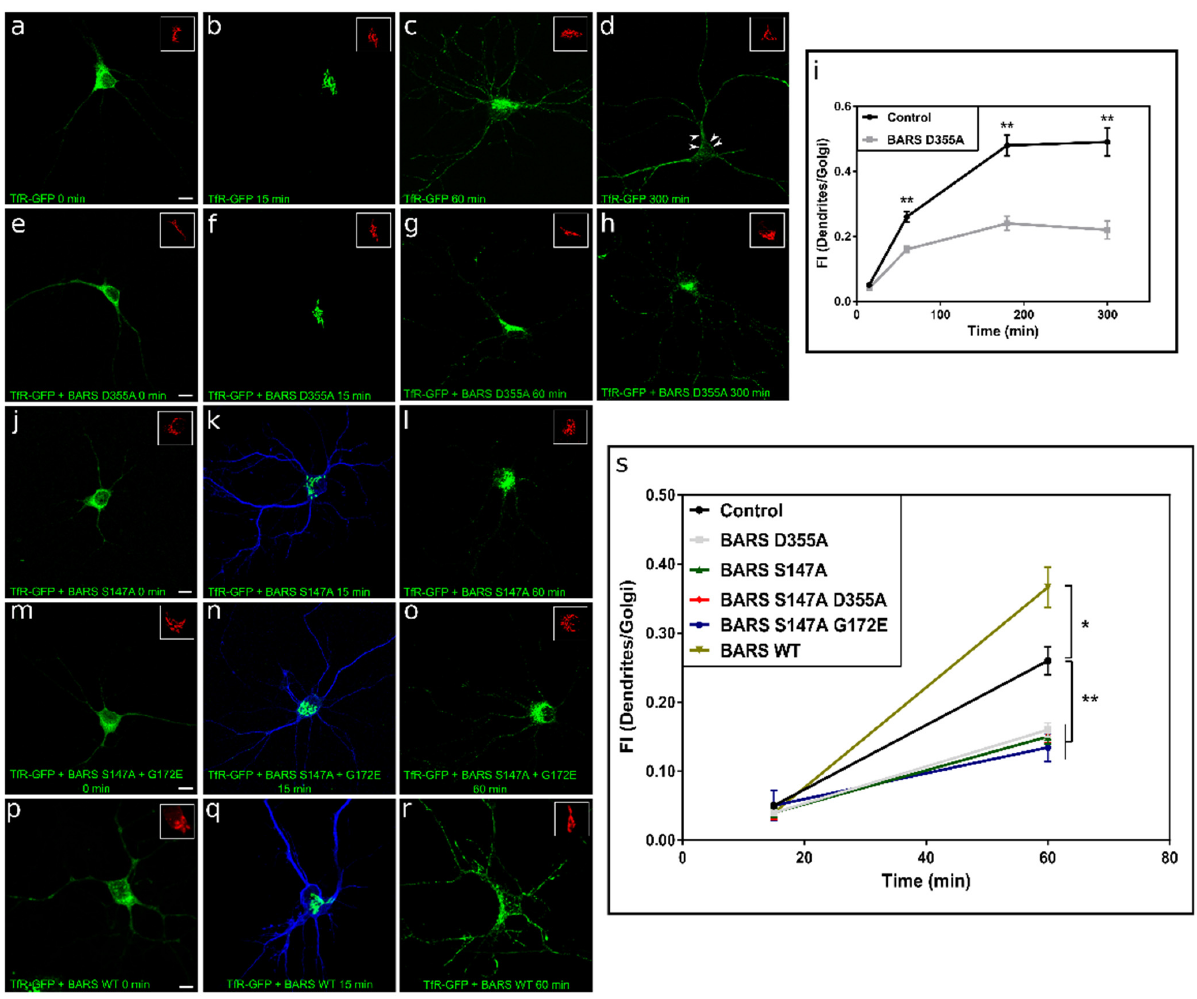
Figure 4. BARS regulates trafficking of TfR. ( a – h ) A series of confocal images showing the distribu- tion of ectopically-expressed TfR-GFP-FM4 alone or after co-transfection with BARS D355A. The distribution of TfR-GFP-FM4 is indicated at different time points after the addition of DD solubilizer. Inset, distribution of the Golgi apparatus marker TGN38 (red). In control cells (GFP-transfected) most of the TfR-GFP labeling disappeared from the Golgi region 300 min after the addition of DD ( d ); the arrowheads in ( d ) indicate the presence of the labeling close to the dendritic plasma membrane. By contrast, in neurons co-expressing the BARS fission-defective mutant most of the labeling remains in the Golgi area ( h ). Scale bar: 10 µ m. ( i ) Graphs showing the fluorescent intensity (FI) ratio between TfR-GFP labeling in dendrites and the Golgi area at 15, 60, 180, and 300 min after the addition of DD solubilizer in control and in neurons expressing BARS D355A mutant. ( j – o ) A series of confocal images showing the distribution of ectopically-expressed TfR-GFP-FM4 after co-transfection with BARS S147A (blue in k) or BARS S147A G172E (blue in n). The distribution of TfR-GFP-FM4 is indicated at different time points after the addition of DD solubilizer. Inset, distribution of the Golgi apparatus marker TGN38 (red). Scale bar: 10 µ m. ( p – r ) A series of confocal images showing the distribution of ectopically-expressed TfR-GFP-FM4 after co-transfection with BARS WT (blue in ( q )). The distribution of TfR-GFP-FM4 is indicated at different time points after the addition of DD solubi- lizer. Inset, distribution of the Golgi apparatus marker TGN38 (red). Scale bar: 10 µ m. ( s ) Graphs showing the fluorescent intensity (FI) ratio between TfR-GFP labeling in dendrites and the Golgi area at 15 and 60 min after the addition of DD solubilizer in control and in neurons co-expressing BARS WT or different mutants. For all experiments 9 to 15 neurons were quantified pooled from at least three independent cultures. Graphs represent mean ± S.E.M.; * p < 0.05, ** p < 0.01; one-way ANOVA and Tukey’s post hoc